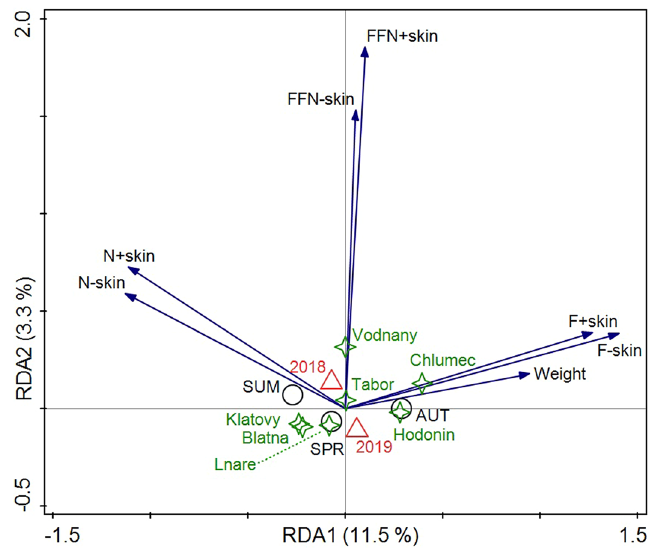
Figure 1. Ordination plot generated by Redundancy analysis (RDA) of functional traits (explained data) and company, sampling year and season as categorial data. Functional traits are displayed by arrows and categorial data by centroids. N + skin—nitrogen in filet with skin, N-skin—nitrogen in filet without skin, FFN + skin— fat-free N in filet with skin, FFN-skin—fat-free N in filet without skin, SPR—spring, SUM—summer, AUT— autumn.